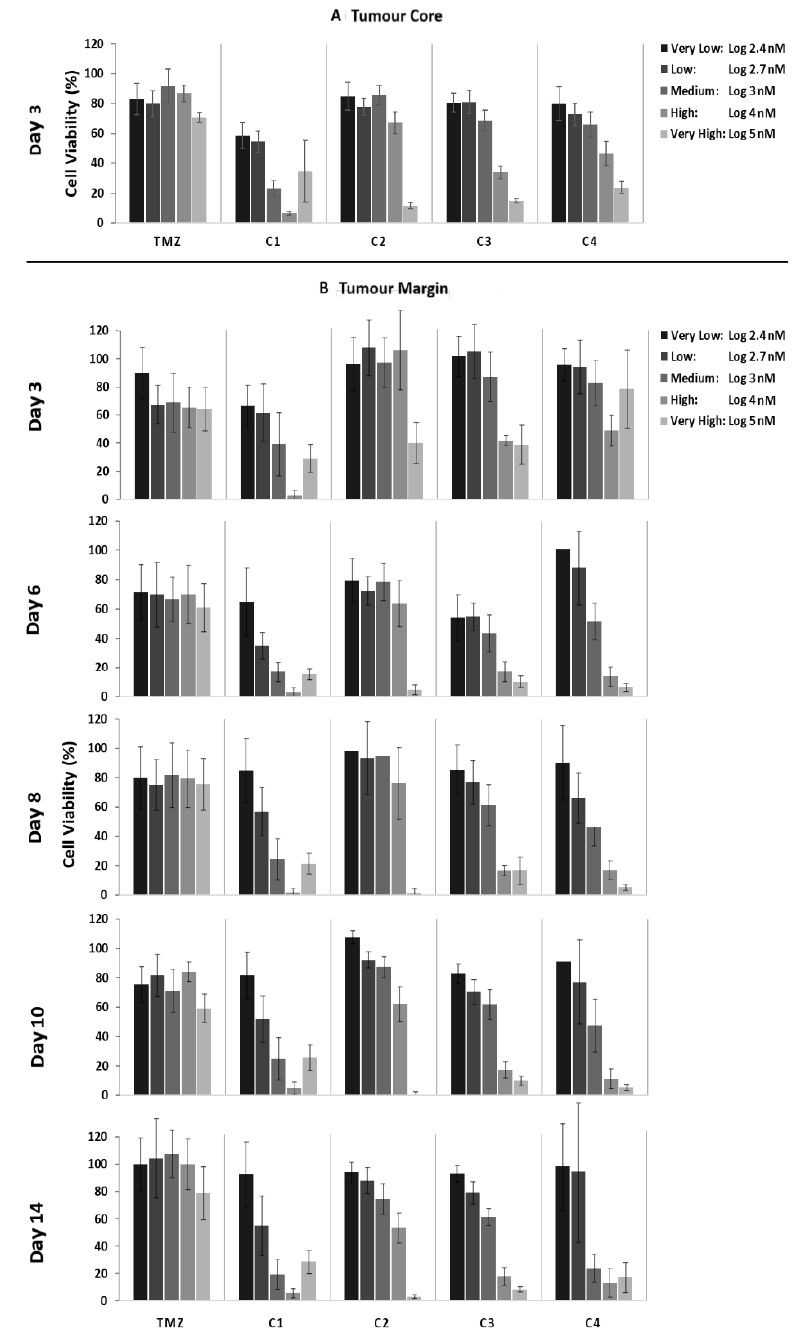
Figure 3. Dose evaluation study of patient-derived primary cells tested at Log 2.4, 2.7, 3, 4 and 5 nM drug concentrations using MTT assay. ( A ) Average ( n = 9) cell viability data for the tumour core samples are 3 days of treatment with very low (Log 2.4 nM), low (Log 2.7 nM), medium (Log 3 nM), high (Log 4 nM) and very high (Log 5 nM) doses. ( B ) Average ( n = 5) cell viability data tumour margin samples after 3, 6, 8, 10 and 14 days of treatment with very low (Log 2.4 nM), low (Log 2.7